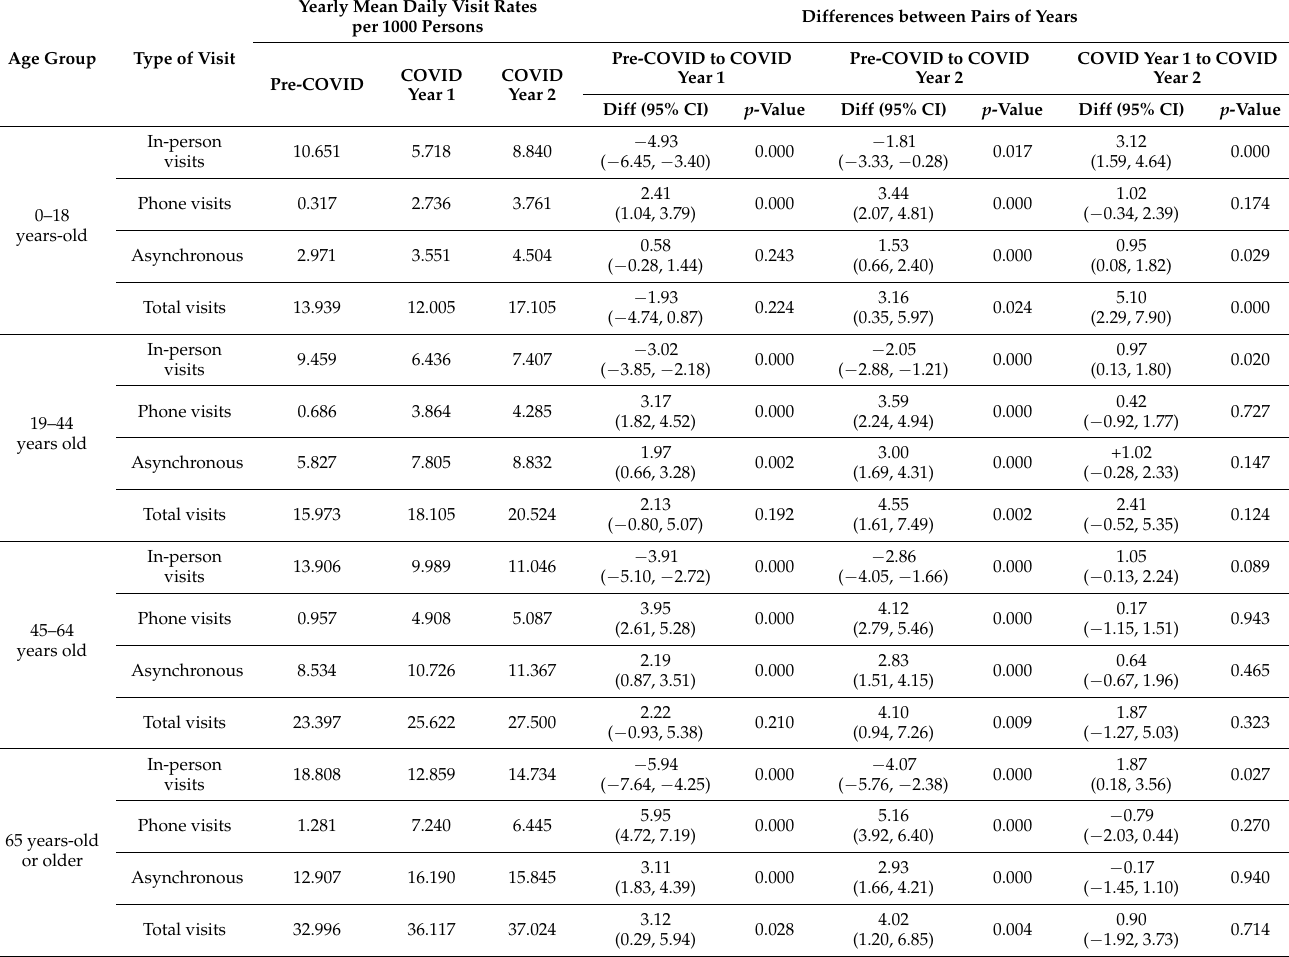
Table 3. ANOVA of visits by